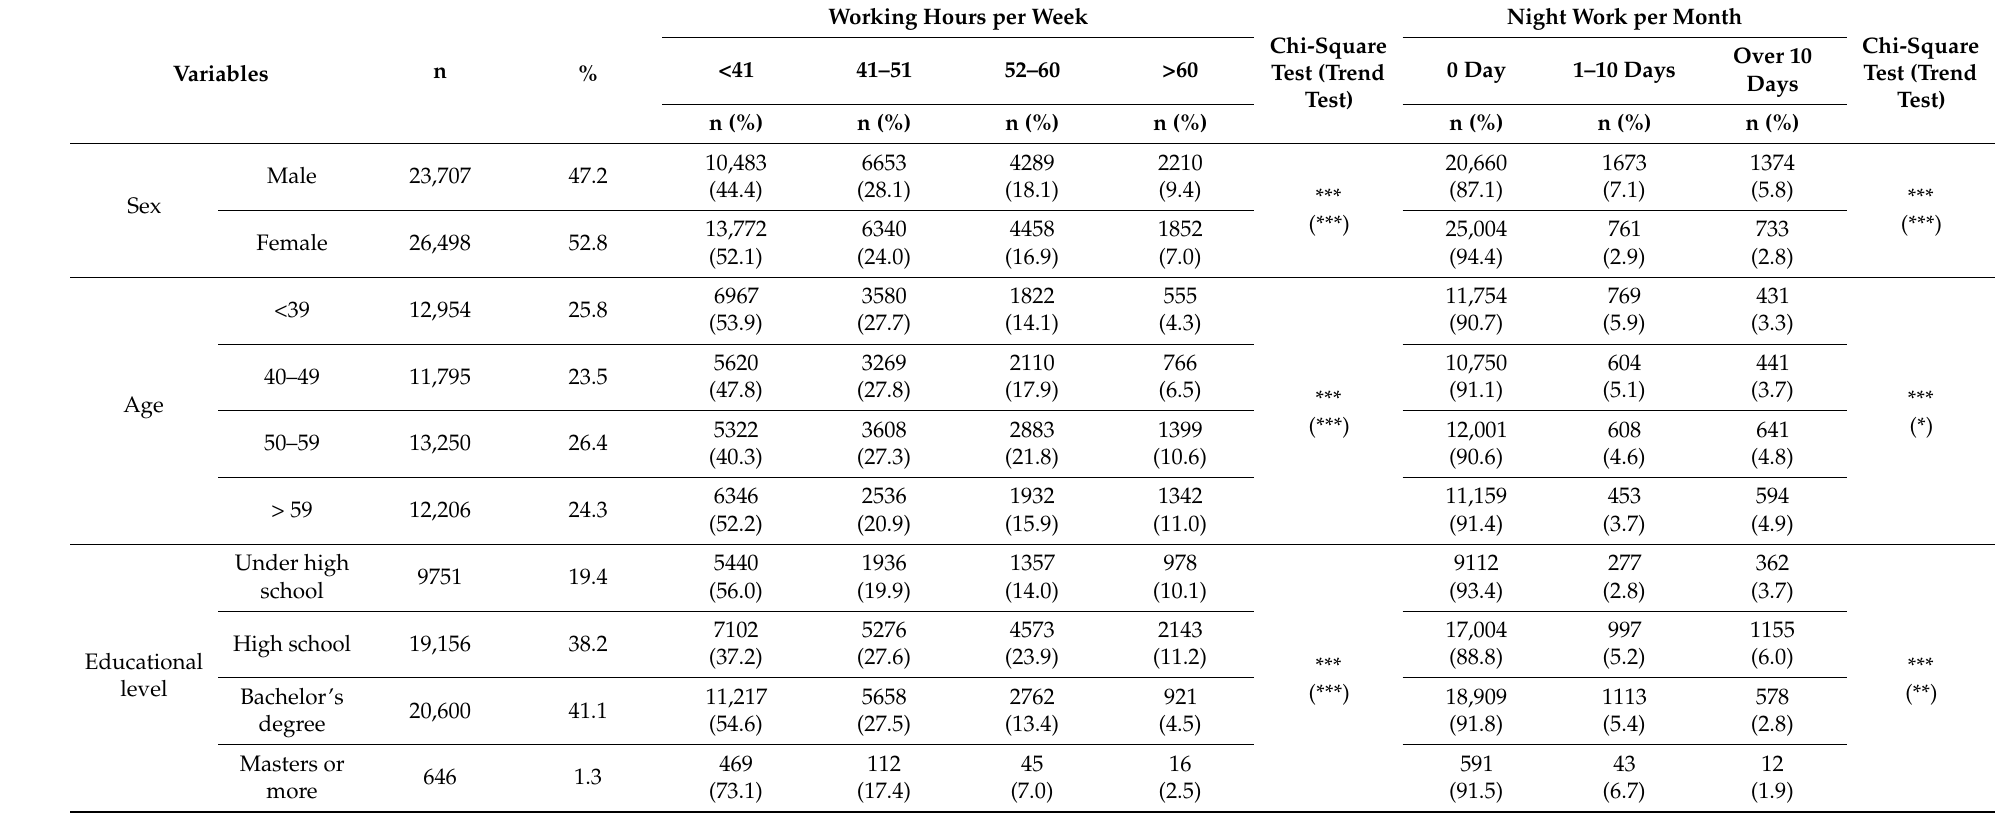
Table 1. Distributions of demographic variables according to working hours per week and night